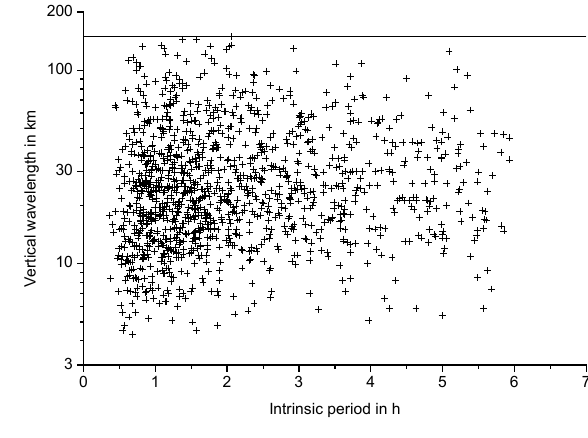
Figure 9: As in Figure 8, but for the vertical wave characteristics. Fig. 9. As in Fig. 8, but for the vertical wave characteristics.